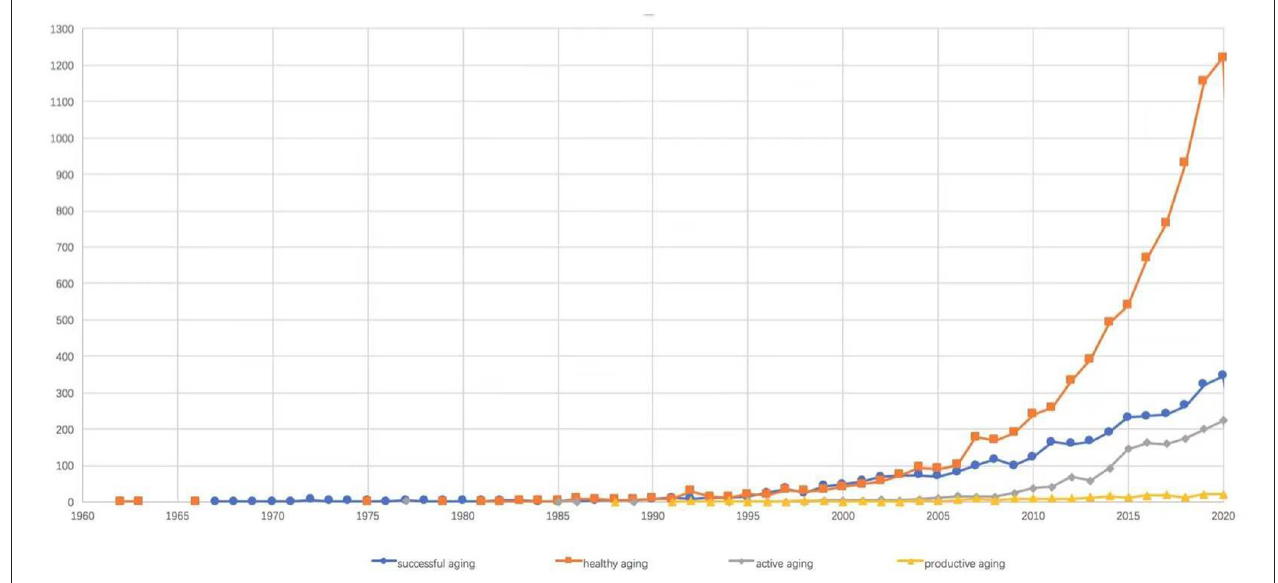
FIGURE 1 | Annual distribution map of aging articles. Data resource: Web of Science,